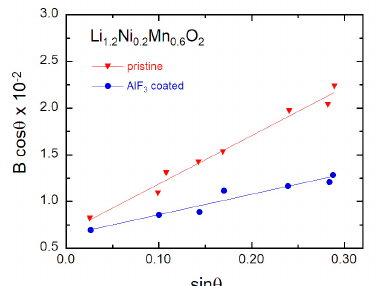
Figure 4. Analysis of the full-width at half-maximum (FWHM) of the XRD reflections according to Equation (1).